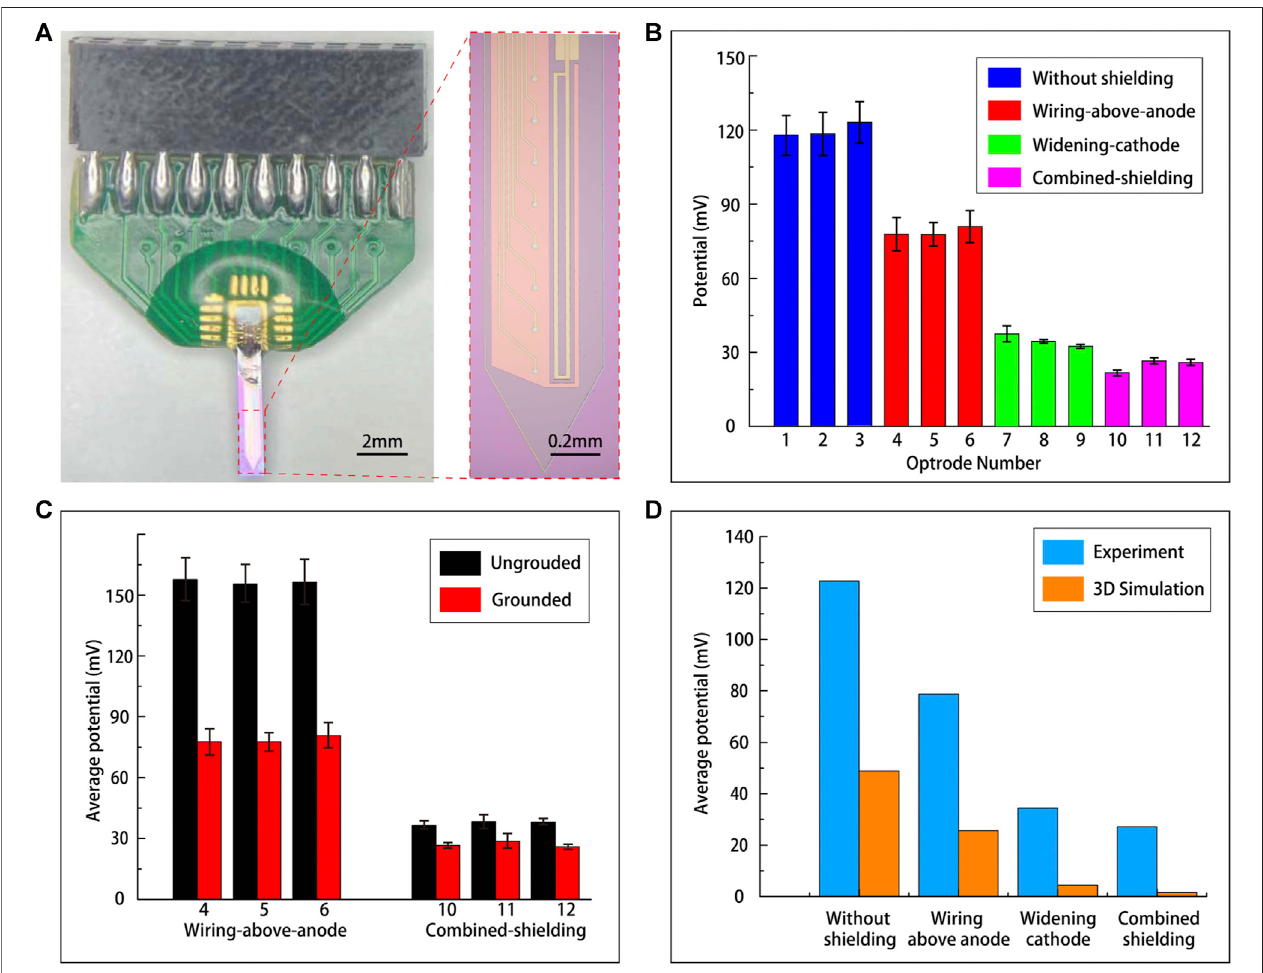
FIGURE5|(A) Thecombined-shieldingoptrodepackagedonPCB. (B) Theshieldingeffecttestresultsoffouroptrodetypes(threedevicesforeachtypeandeight electrodesforeachdevice).Theerrorbarrepresentsstandarddeviations(SD)andthehorizontalaxisisthenumberofthedevice. (C) Thecomparisonofungroundedand grounded shielding layer in wiring-above-anode and combined-shielding optrodes. The error bar represents standard deviations (SD) and the horizontal axis is the number of the device. (D) The comparison of experimental results and 3D simulation results under different shielding methods.